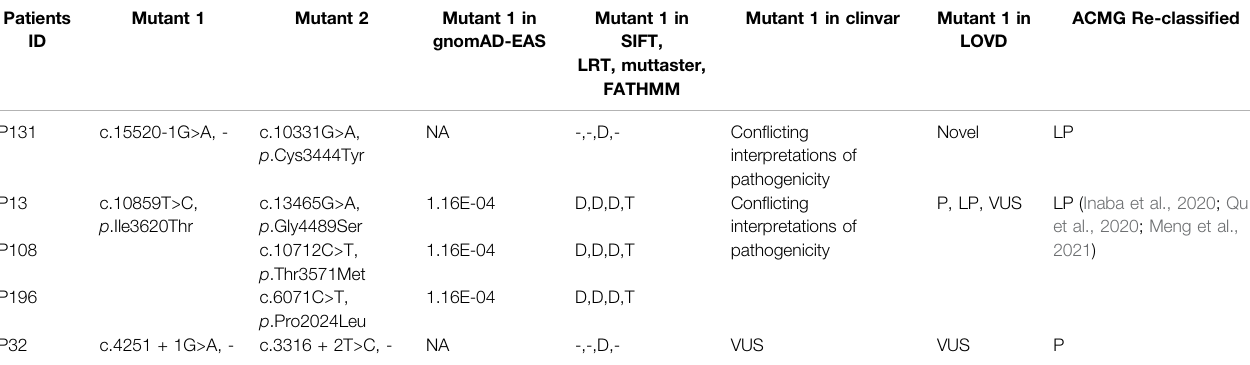
TABLE 1 | Three variants were reclassi fi ed as P or LP mutations according to ACMG guidelines in our USH2A-IRD study cohort. Patients